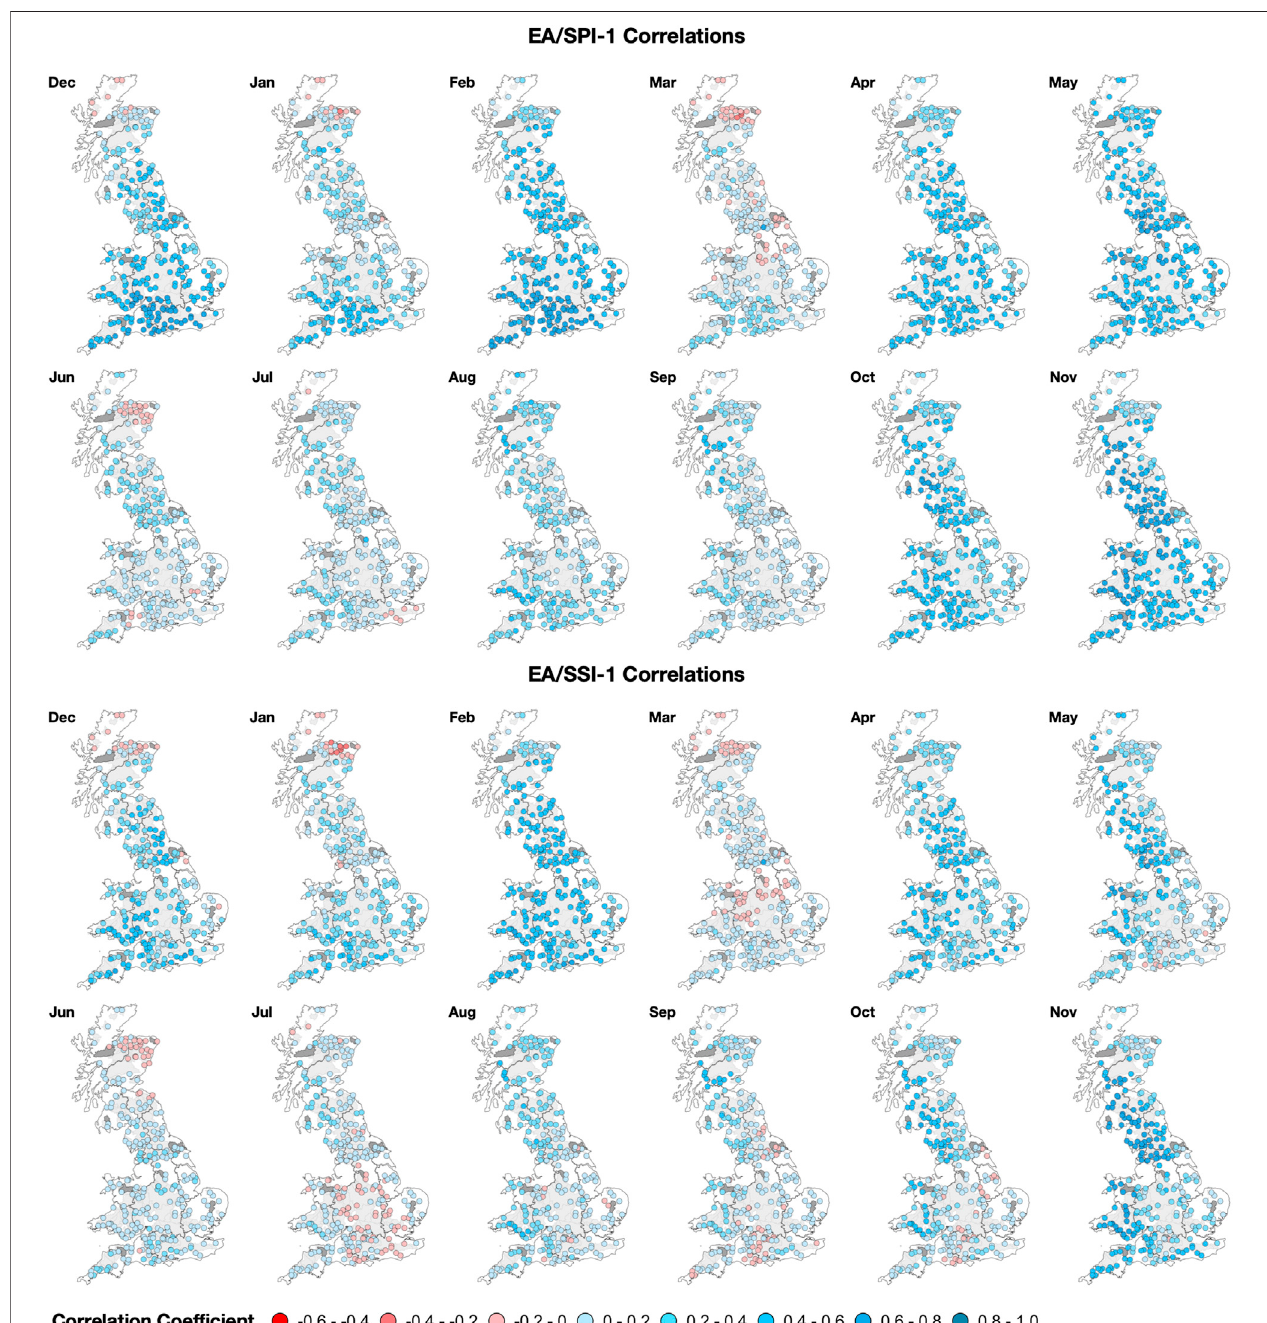
FIGURE3| MonthlycorrelationsbetweentheEAandSPI-1/SSI-1forthe291catchmentsacrossGreatBritain.Notethedifferenceinstrengthbetweenthepositive correlations in the during winter (DJF) compared to the slightly weaker correlations in summer months (JJA).